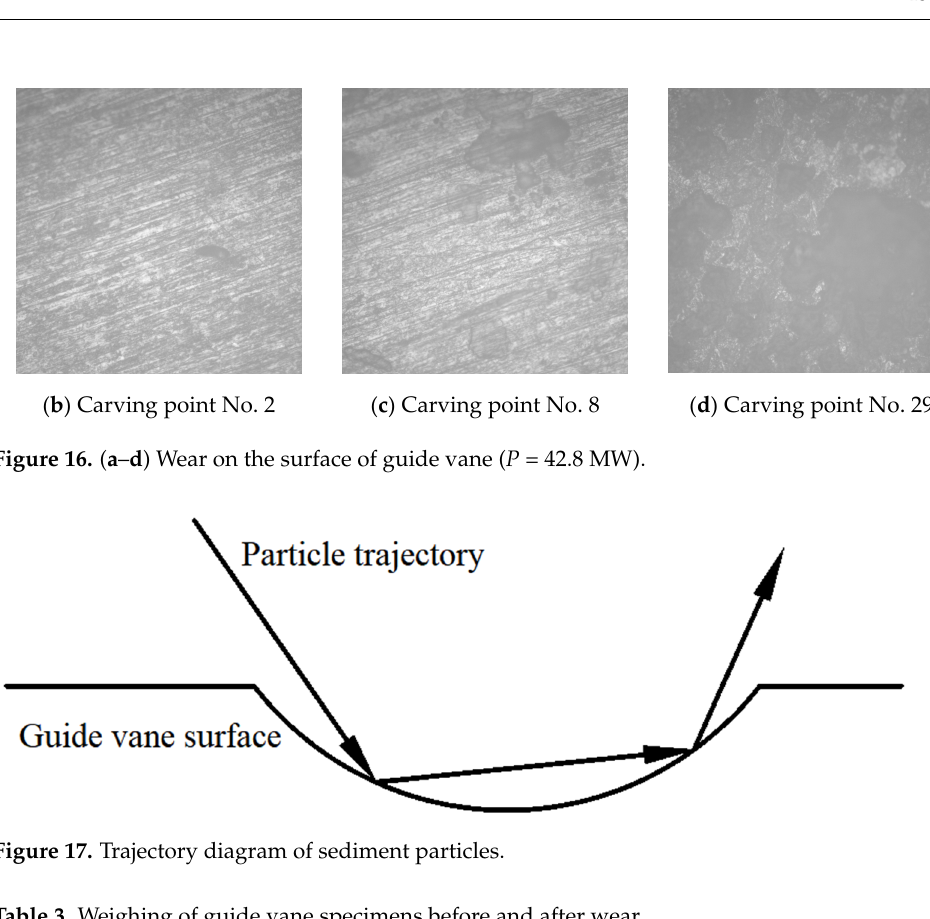
( d ) Carving point No. 29 Figure 16. ( a – d ) Wear on the surface of guide vane ( P = 42.8 MW). The surface of the guide vane before grinding and polishing will have a lot of small uneven pits, the large particle size of the sediment particles hitting these pits will make the area of the pits increase, and the small particle size of the sediment particles will form refraction inside the pits causing secondary or even multiple collision wear, although the secondary collision is smaller compared to the first collision kinetic energy, but due to the pushing effect of the water will give the sediment particles new kinetic energy, intensify ‐